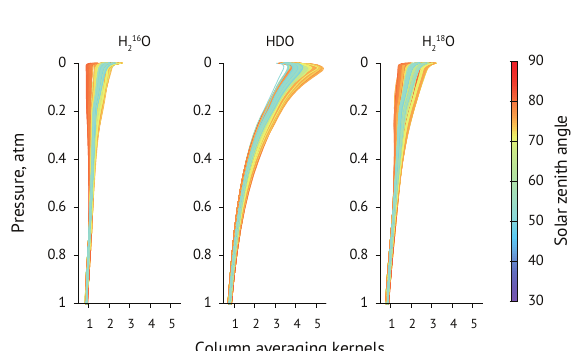
O, HDO and H 18 2